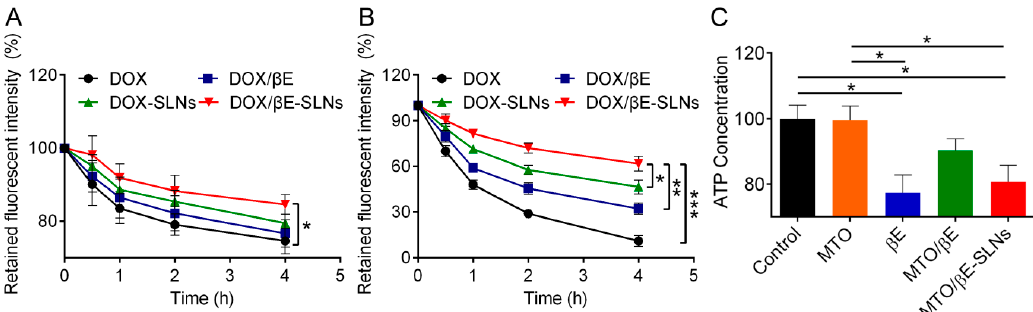
Figure 4. ( A , B ) The amount of DOX retained in the K562 cells ( A ) and K562 / DOX cells ( B ) after treating with DOX, DOX / β E, DOX-SLNs, and DOX / β E-SLNs for 4 h at 37 ◦ C. ( C ) The amount of intracellular ATP in K562 / DOX cells after treatment with MTO, β E, MTO / β E, and MTO / β E-SLNs. Data are presented as means ± SD, n = 3. * p < 0.05, ** p < 0.01, and *** p <